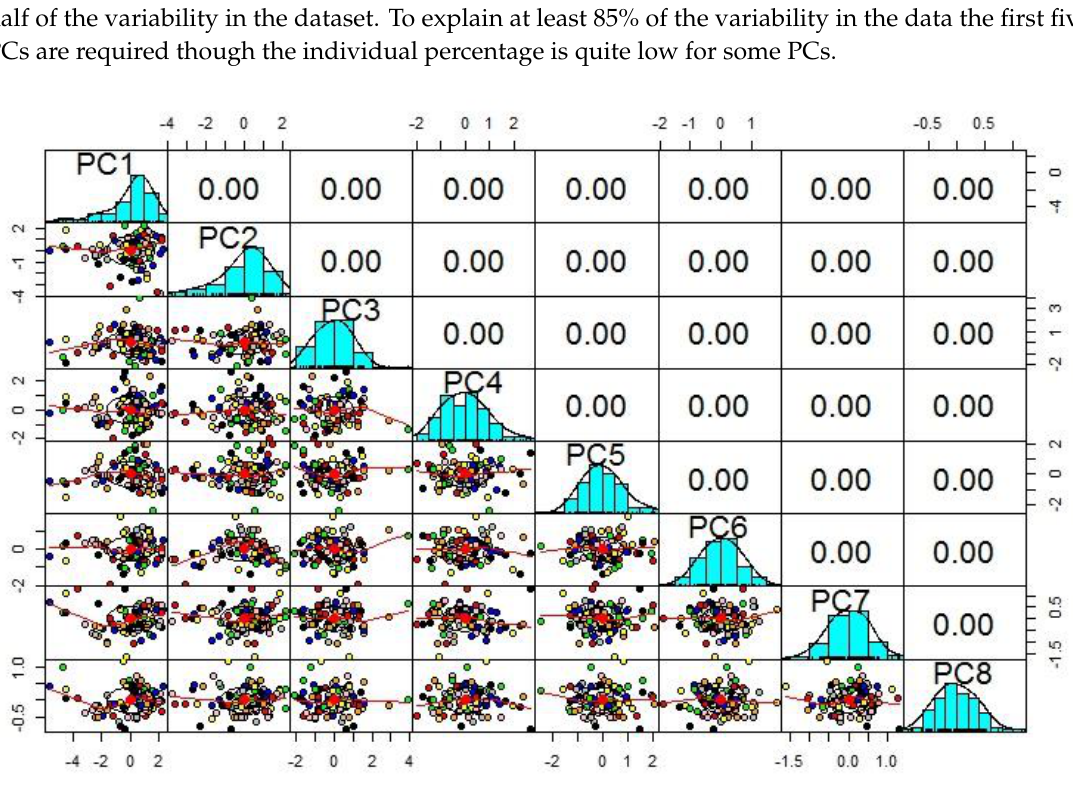
Figure 3. Uncorrelated principal components (PCs) after application of PCA. Table 3. Eigenvalue of different components and their significance level.